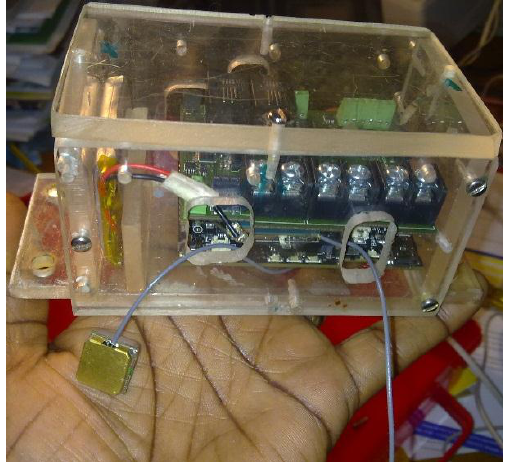
Figure 4. Sensor board